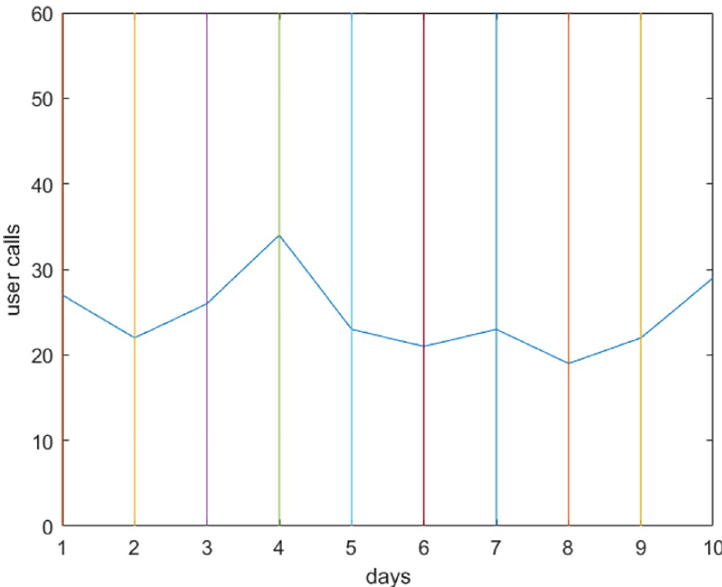
Fig 8. Selecting an SP to represent non-zero derivative periods. All SPs are selected on the curve.